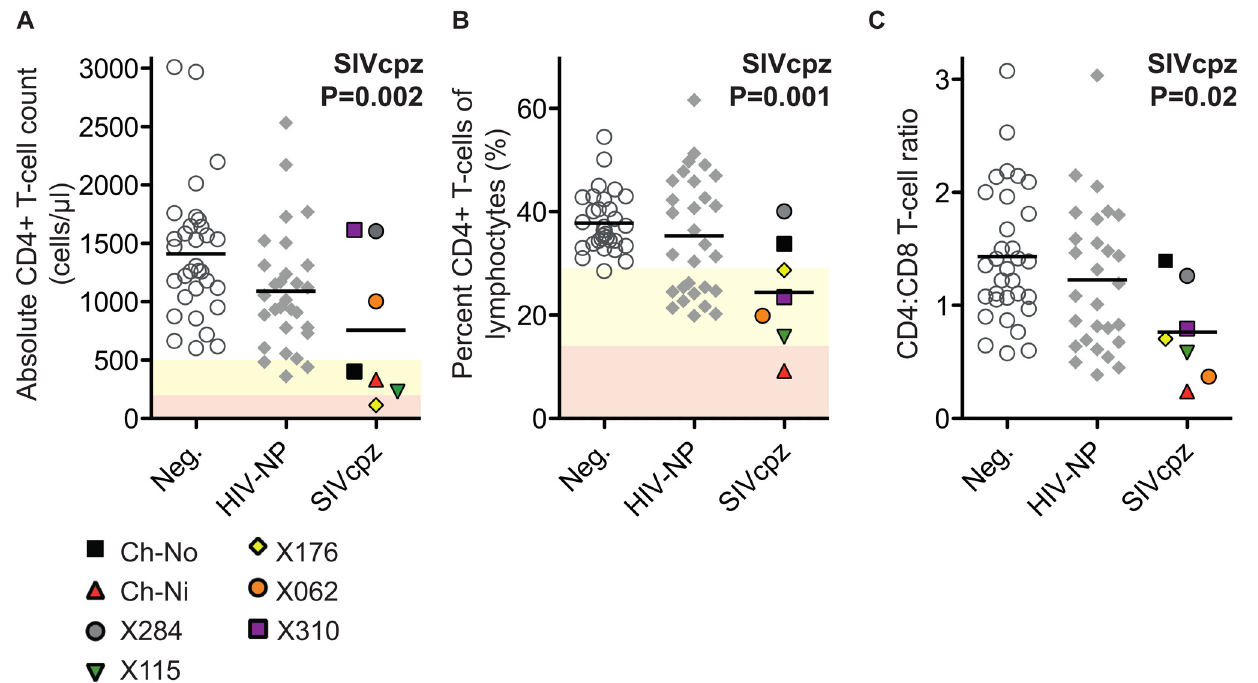
Fig 1. Comparison of CD4+ T-cell levels in uninfected, HIV-1 infected and SIVcpz infected animals. Levels of peripheral blood CD4+ T-cells were quantified by flow cytometry in chimpanzees that were uninfected (Neg., n = 32), HIV-1 non-progressors (HIV-NP, n = 29), or SIVcpz infected (SIVcpz, n = 7). Levels were quantified as (A) Absolute CD4+ T-cell counts, (B) percentage CD4+ T-cells of the lymphocyte population, and (C) the CD4:CD8 T-cell ratios. Shading corresponds to CDC categorisation for CD4+ T-cell levels (absolute count and percentage of lymphocytes) in HIV-1 infected humans, where yellow indicates stage two and red indicates stage one. P value shown indicates that SIVcpz infection was a significant predictor of reduced CD4+ T-cell levels, in a general linear model including age, gender, and HIV-1 and SIVcpz status. Full details of analysis are available in S1 – S3 Tables. Each SIVcpz infected animal is represented by a unique symbol, as indicated in the legend. Horizontal black bars indicate the mean value in each group. Data shown for the SIVcpz infected animals are the most recent available, detailed in Table 1 as the time post infection for absolute T-cell count.